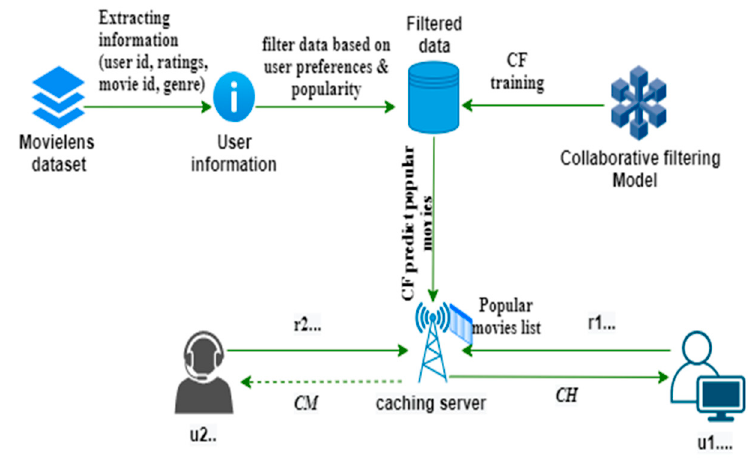
Figure 4. Popularity prediction module.